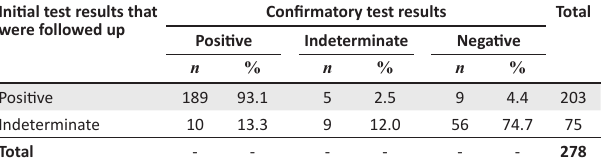
TABLE 2: Comparison of results of the initial reactive infant polymerase chain reaction tests and confirmatory tests conducted at Tygerberg Hospital, Cape Town, South Africa, between July 2017 and June 2019.